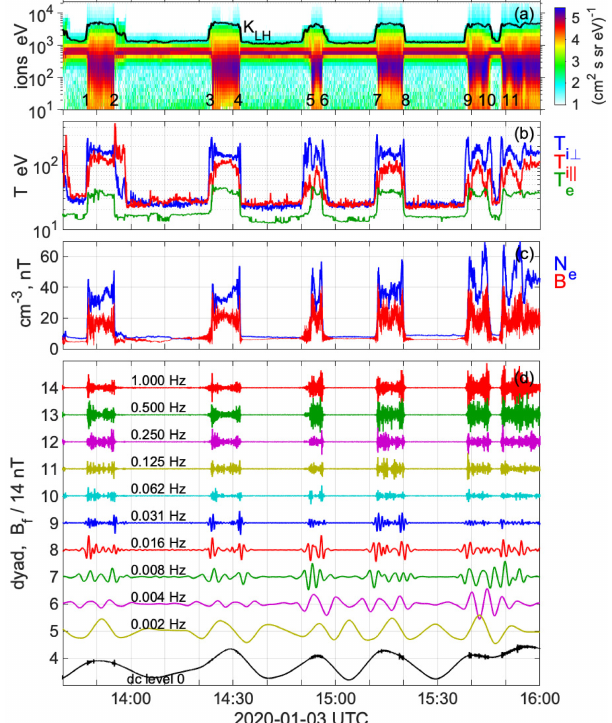
Figure 1. A series of 11 encounters with an oscillatory bow shock by the MMS3 spacecraft on 3 January 2020. (a) Omnidirectional ion flux measured by the Fast Plasma Investigation (FPI) in energy range 10–20keV. Overlaid is the energisation capacity of lower hy- brid waves given by Eq. (3). (b) The ion temperatures T i ⊥ and T i (cid:107) and the electron temperature T e = T e ⊥ ≈ T e (cid:107) derived as moments of the distribution functions measured by FPI. (c) The electron number density and the magnitude of the magnetic field. (d) Multiresolu- tion decomposition of the measured magnetic field in the frequency range